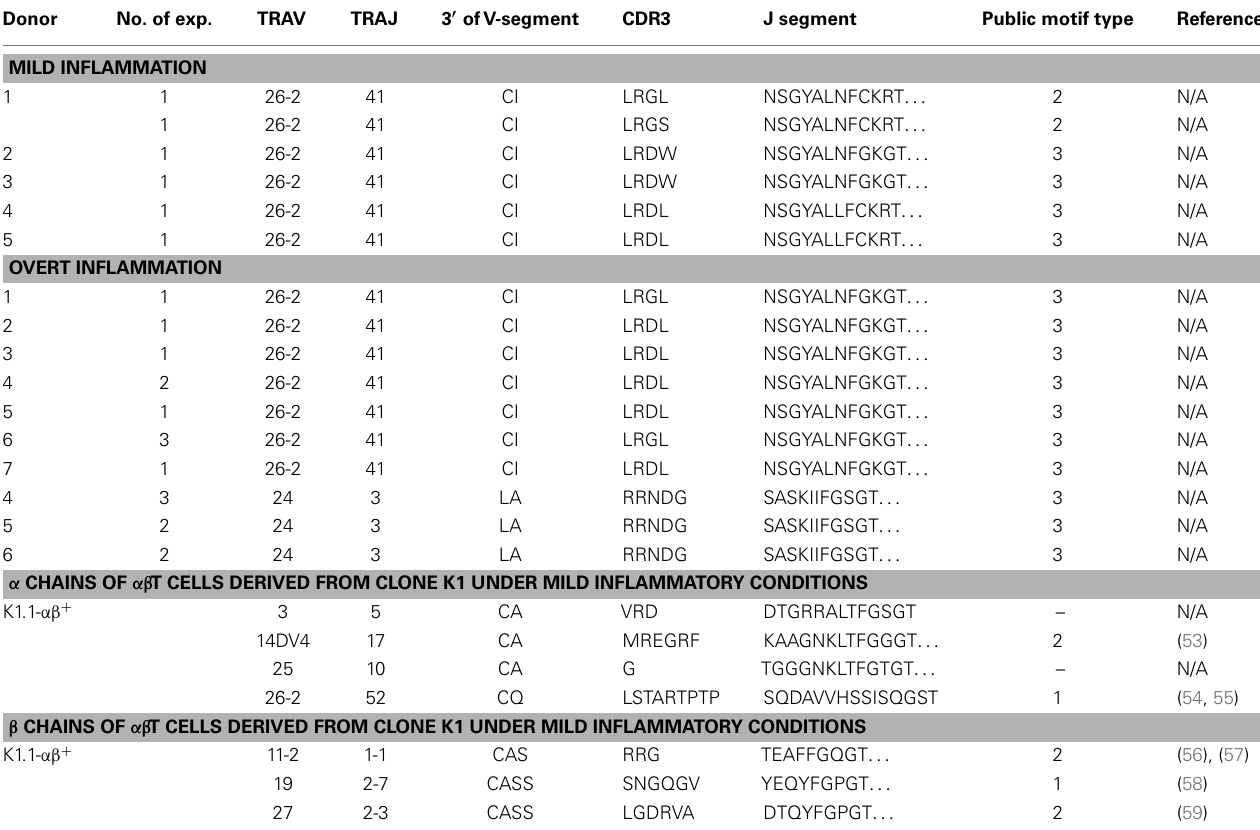
Table 1 | CDR3 region peptide composition of rearrangedTRAV segments in panV δ 1 + T cells induced by mild and overt inflammation and CDR3 regions of rearrangedTRBV andTRAV segments of αβ T cells derived from CD4 + V δ 1 + clone K1-V δ 1 + (K1.1- αβ + ) under mild inflammatory conditions